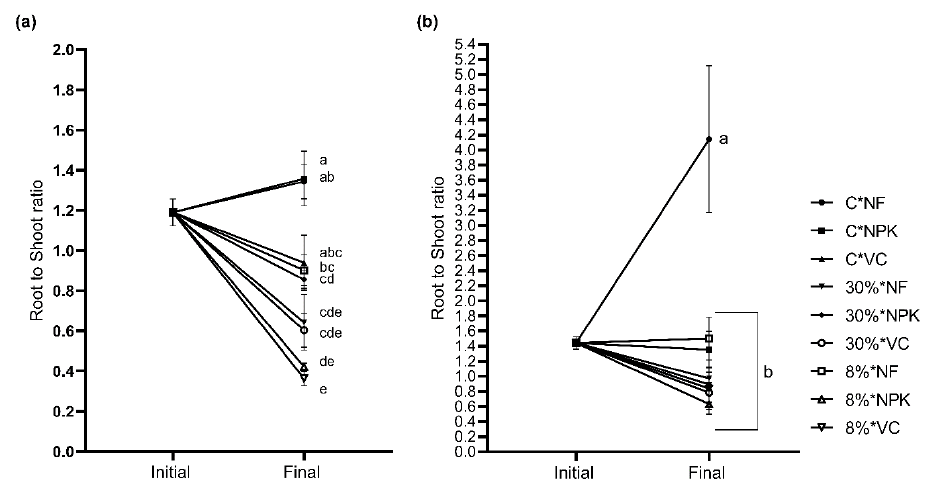
Figure 9. Root-to-shoot ratio of Shorea leprosula Miq. ( a ) and Shorea acuminata Dyer ( b ) in response to the interaction factor, light × nutrient. Alphabets denote significant differences between light × nutrient